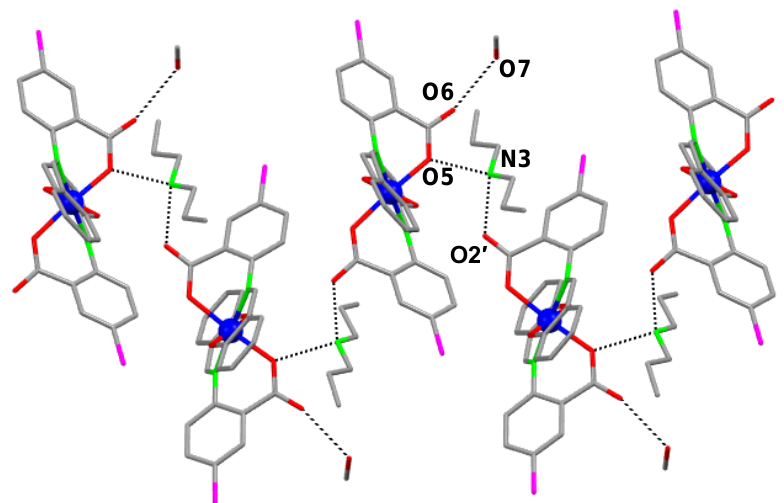
Figure 2. A small portion of the pseudo zig-zag chains formed through the H-bonding interactions (dashed lines) between the Pr 2 NH 2+ counterions, the lattice MeOH molecules, and the carboxylate O atoms of sacb 2- in the crystal structure of 1 ∙MeOH. H atoms are omitted for clarity. Color scheme as in Figure 1.